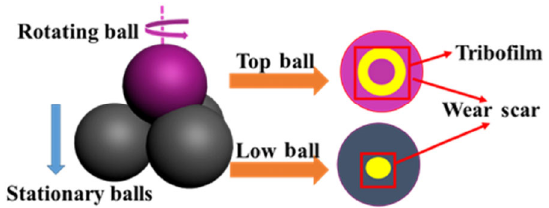
Fig. 2 Contact mode of steel balls in four-ball tester.